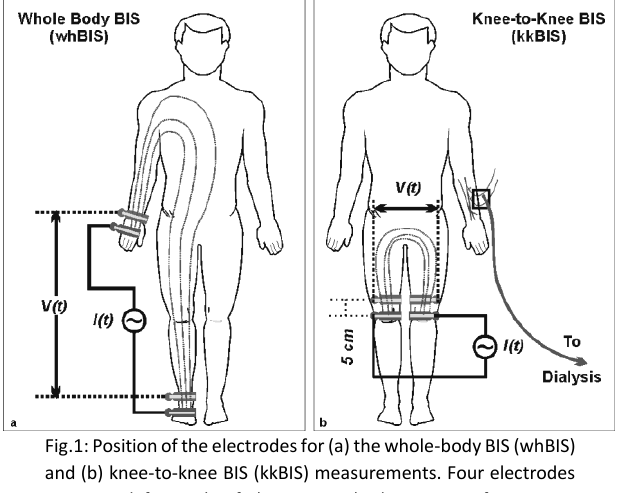
Fig.1: Position of the electrodes for (a) the whole-body BIS (whBIS) and (b) knee-to-knee BIS (kkBIS) measurements. Four electrodes were used for each of the BIS methods, i.e. two for current injection I(t) and two for voltage sensing